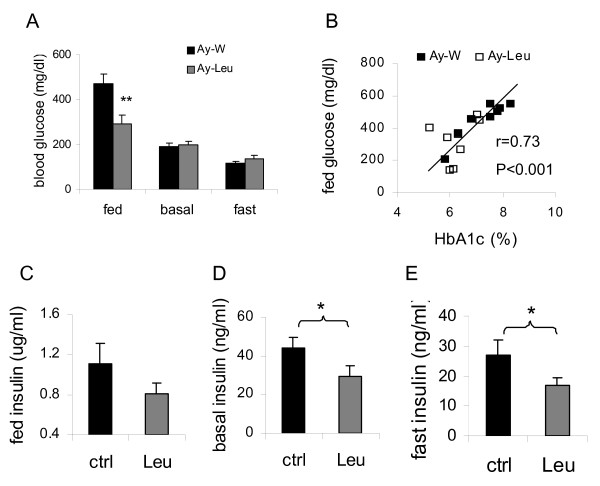
Leucine supplementation improves glucose and insulin homeostasis in Aymice. A: Plasma glucose levels in the fed, basal and fast states after 4 months of leucine treatment. B: Positive correlation between HbA1c levels and plasma glucose levels in the fed state, which fits the following equation (fed glu = -392 + 116 × HbA1c, F = 18.1, Standard error of estimation 93.184, F = 18.1, p < 0.001). C-E: Plasma insulin levels in the fed, basal and fast states after 4 months of leucine treatment. * and ** indicate p < 0.05 and 0.01, control vs. leucine-treated, respectively, n = 8.